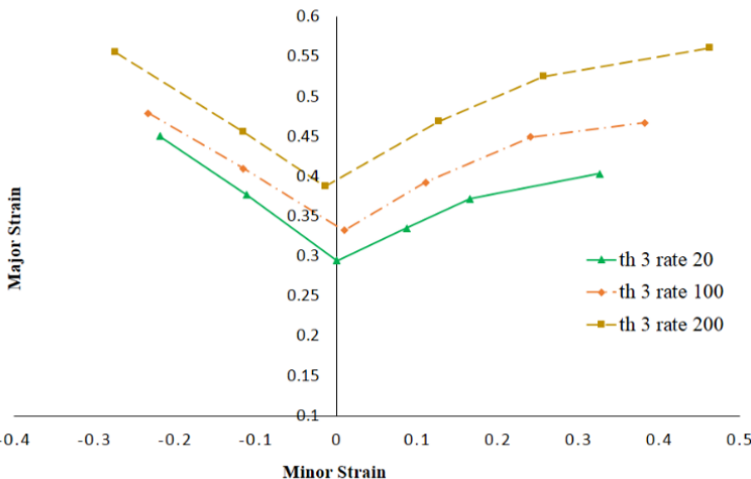
Figure 14. FLDs at different speeds for a 3 mm-thick sheet.